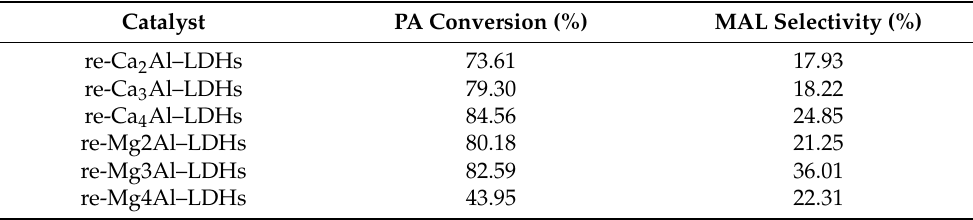
Table 1. Results of the aldol condensation reaction with re-M x Al–LDHs catalysts.